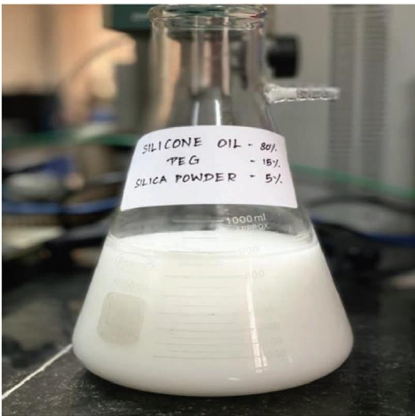
Figure 1: Ultrasonicated STF with 80% silicone oil, 15% PEG, and 5% silica